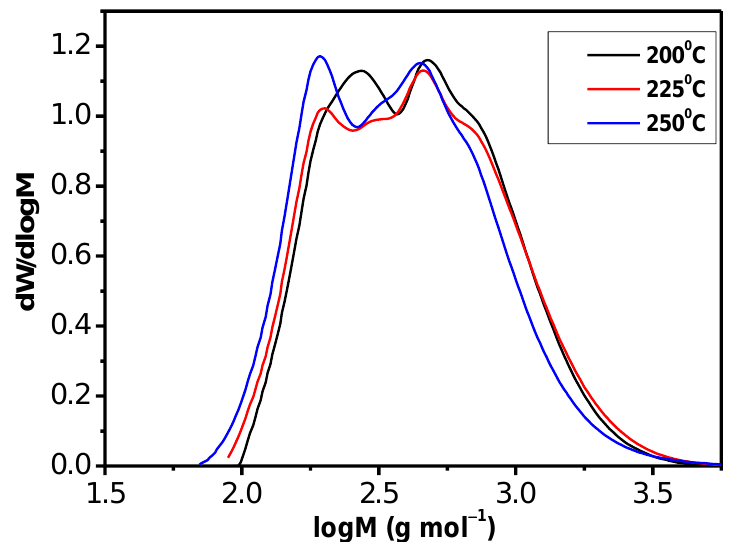
Figure 9. The effect of temperature of spruce wood RCF for 3 h over the 3RS450 catalyst on the molecular weight distribution of the liquid products. Table 6. Effect of temperature of spruce wood RCF over the 3RS450 catalyst for 3 h on the molec- ular weight characteristics of the liquid products.